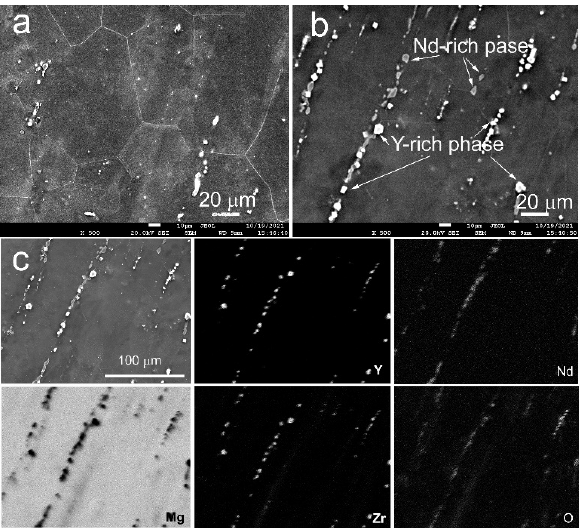
Figure 2. SEM structure of the alloy WE43 in the initial state ( a , b ) and elemental mapping ( c ). MAD is seen to have resulted in a significant microstructure refinement. As a result of deformation, the average grain size dropped to 0.93 ± 0.29 μ m (Figure 3a). At the same time, predominantly point reflections on the rings of the electron diffraction pattern indi- cate the formation of a coarse grain structure with high-angle boundaries (Figure 3b). No